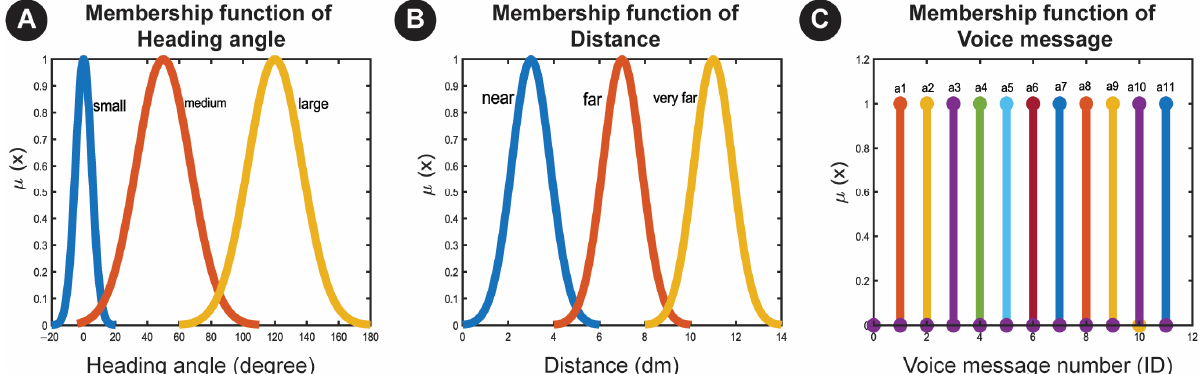
Figure 5. Membership function of ( A ) heading angle and ( B ) distance, which have Gaussian membership functions as a linguistic variable; ( C ) Membership functions of voice message (a: audio), which here has a fuzzy singleton membership function and is not a linguistic variable.